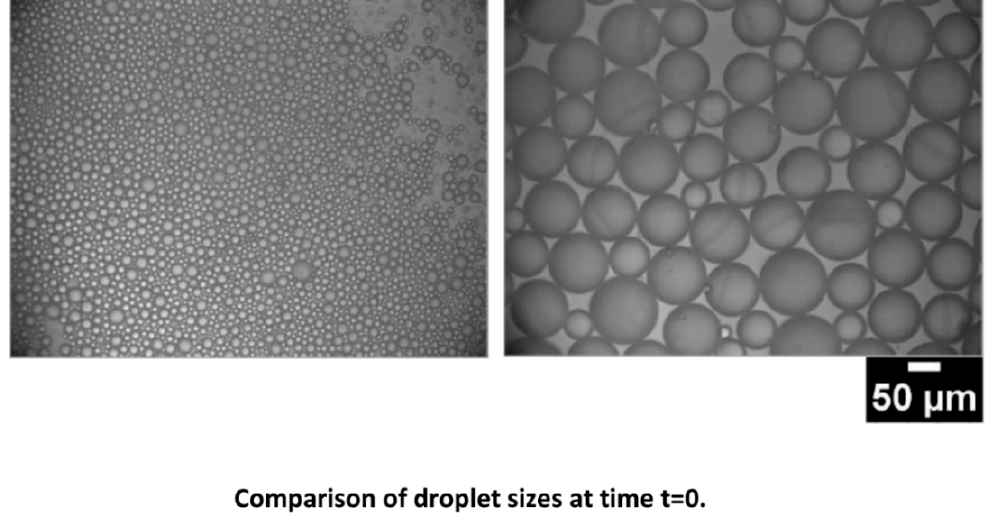
Figure 8. Comparison of photomicrographs of fresh surfactant-stabilized (left photomicrograph) and nanoparticles-stabilized (right photomicrograph) O/W emulsions.